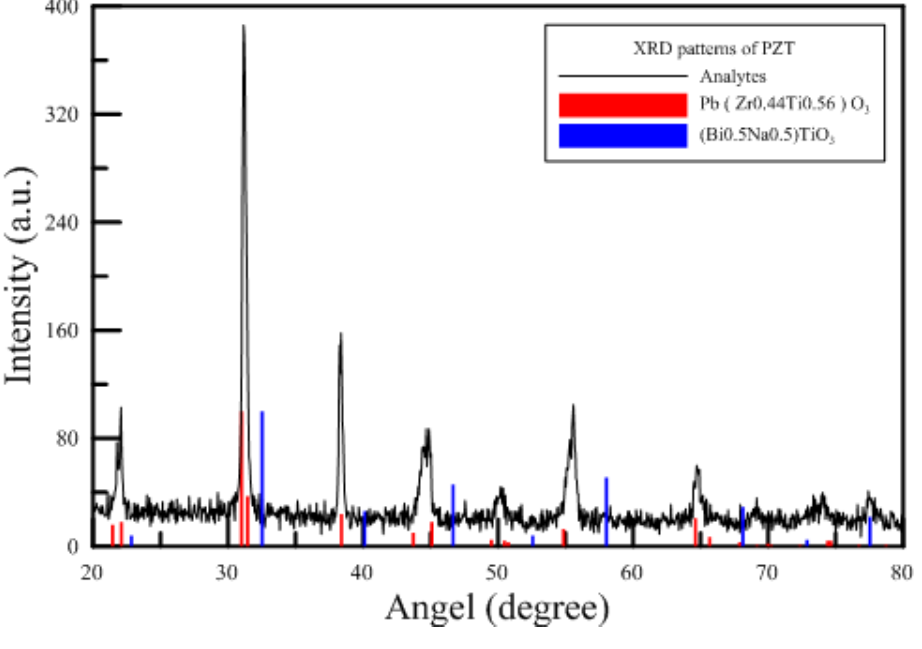
Figure 3. XRD patterns of the present PZT [1].